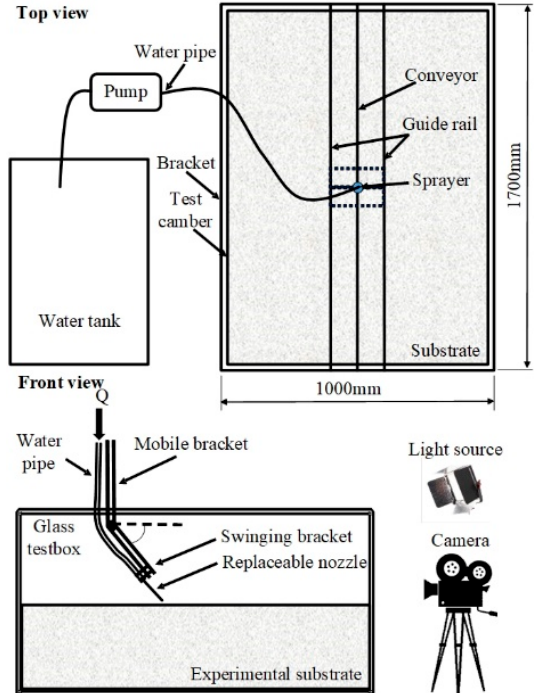
Figure 17. Schematic diagram of experimental analysis platform and observation platform.